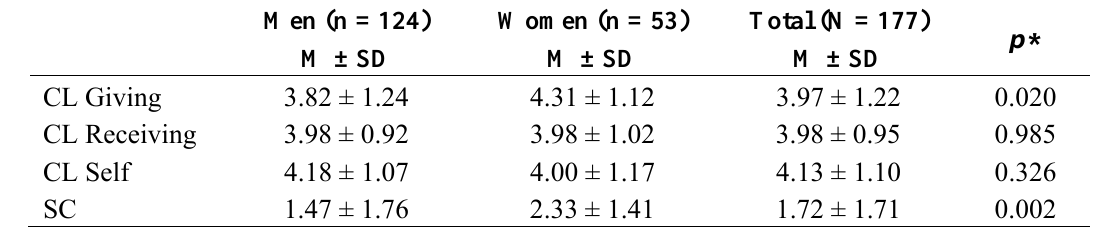
Table 1. Differences between men and women on compassionate love (CL) and spiritual coping